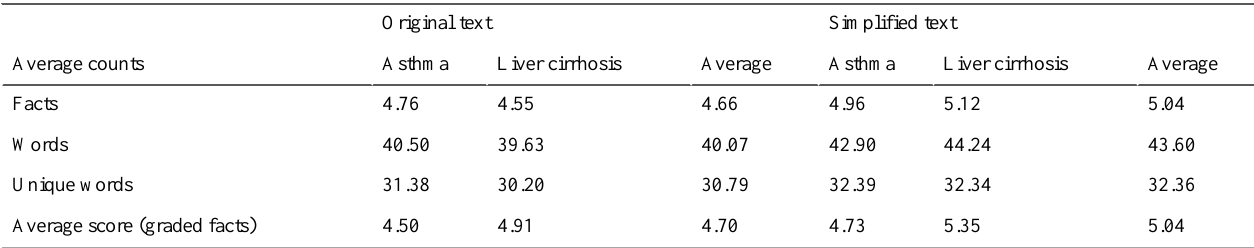
Table 4. Retention of information: mean and standard